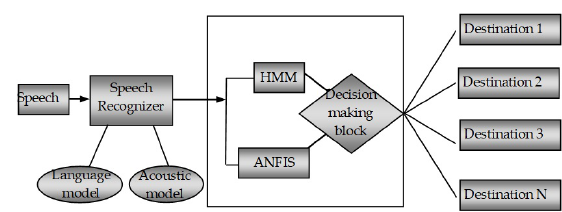
Figure 4: The structure of a hybrid